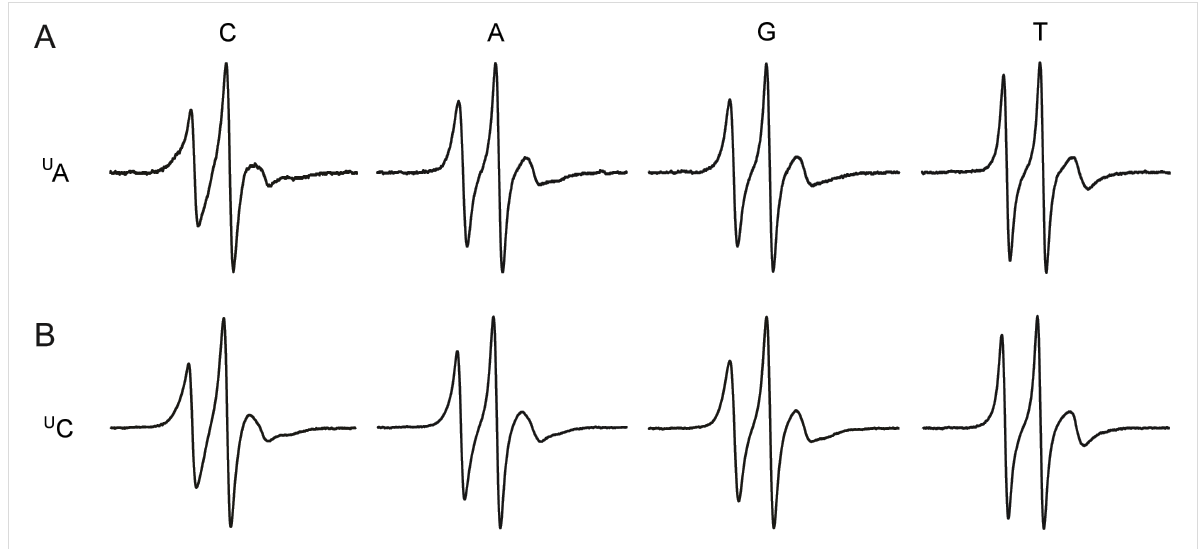
Figure 5: EPR spectra of 14-mer DNA duplex 5 ′ -d(GACCTCG U AATCGTG)•5 ′ -d(CACGATYCGAGGTC) (A), and 5 ′ -d(GACCTCG U CATCGTG)•5 ′ - d(CACGATYCGAGGTC) (B), (10 mM phosphate, 100 mM NaCl, 0.1 mM Na 2 EDTA, pH 7.0) at 10 °C, where U A or U C is paired with either Y = T, C, G or A